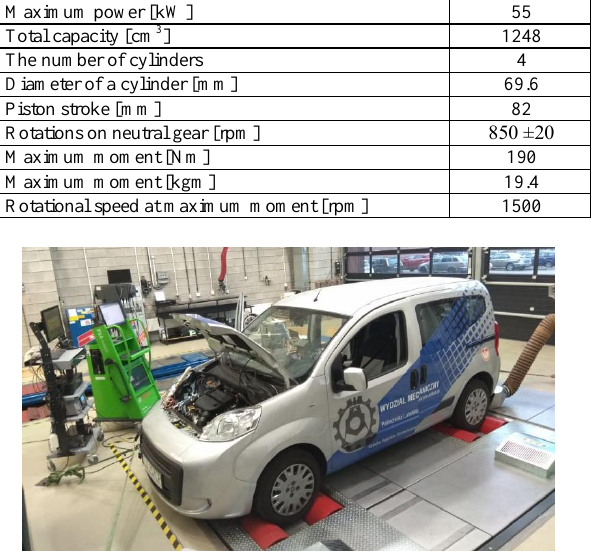
Table. 1 Technical data of the test engine (1.3 MultiJet) [9] Maximum power [KM]